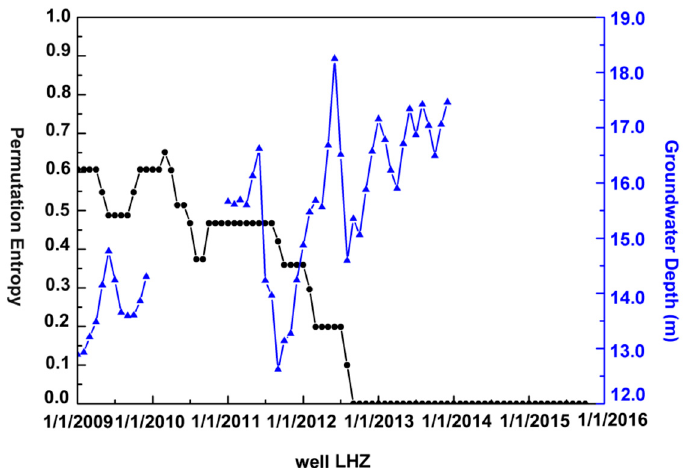
Figure 12. Comparison of the permutation entropy results for well LHZ and the variations in the groundwater level. The blue line indicates the groundwater level variations. The black line represents the PE results. The groundwater data reference datum is the same as that in Figure